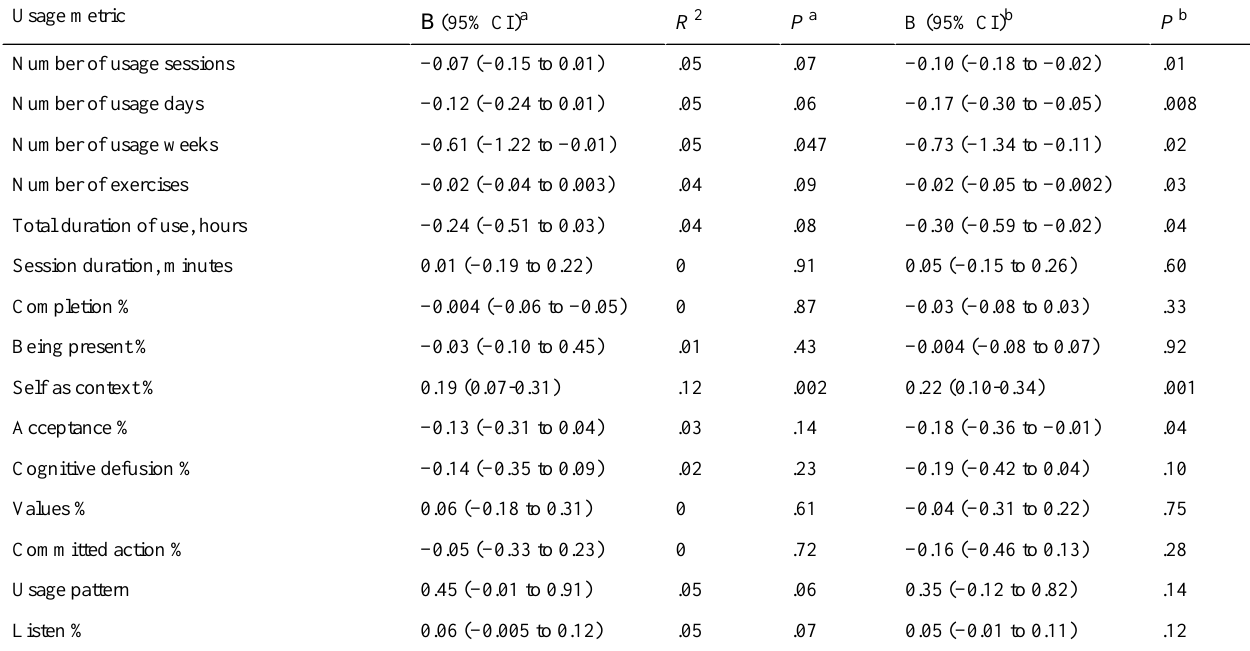
Table 3. Linear regression analyses between usage metrics and change in Acceptance and Action Questionnaire II